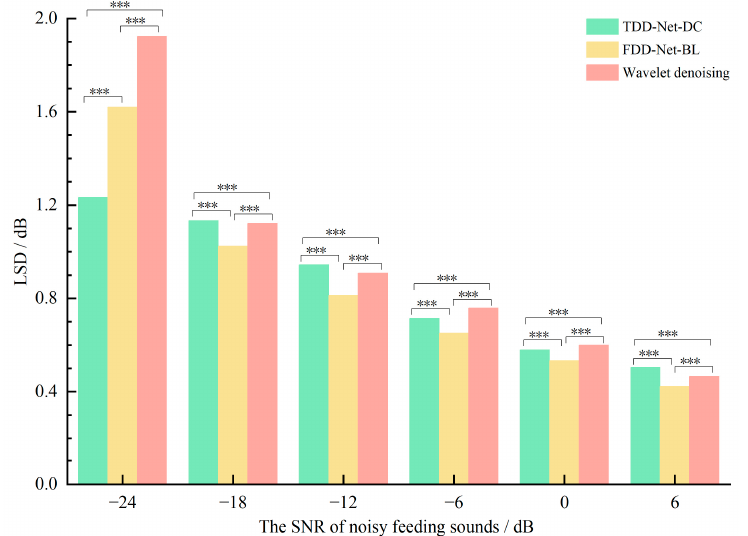
Figure 7. Comparison of the ∆ SegSNRs of different denoising methods at different SNRs, *** means highly significant ( p ≤ 0.001).